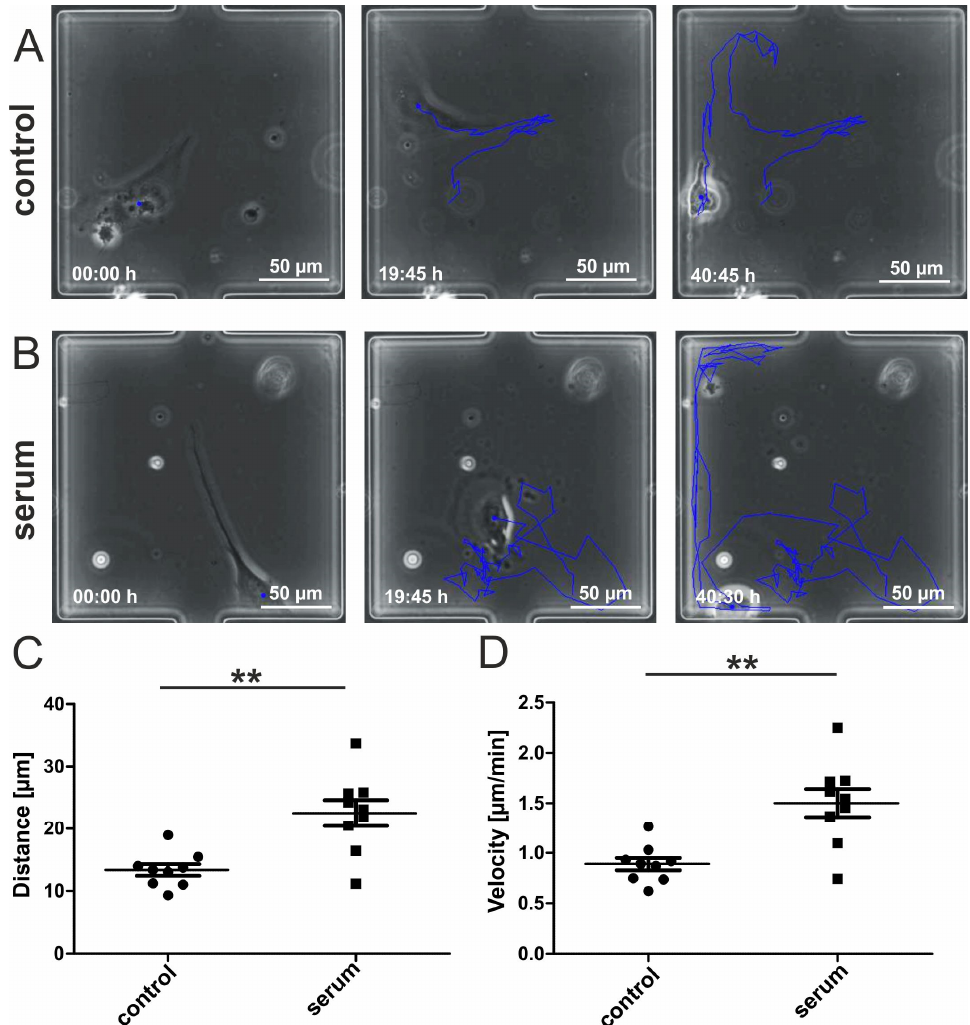
Figure 3. Human blood serum enhances migration behavior of hCSCs. ( A ) Exemplary images of hCSCs cultivated without serum directly after medium switch, after 19:45 h and after 40:45 h. The blue line indicates the migration path. ( B ) Exemplary images of hCSCs cultivated with human blood serum directly after medium switch, after 19:45 h and after 40:30 h. The blue line indicates the migration path. ( C ) Migration distance of hCSCs is significantly increased by the application of human serum. ( D ) Migration velocity of hCSCs is significantly increased by the application of human serum. Data points represent migration dynamics of single hCSCs observed in individual cultivation chambers. Measurements were performed with hCSCs from one donor and blood serum from one donor. Mann-Whitney one-tailed, ** p < 0.005 was considered significant.